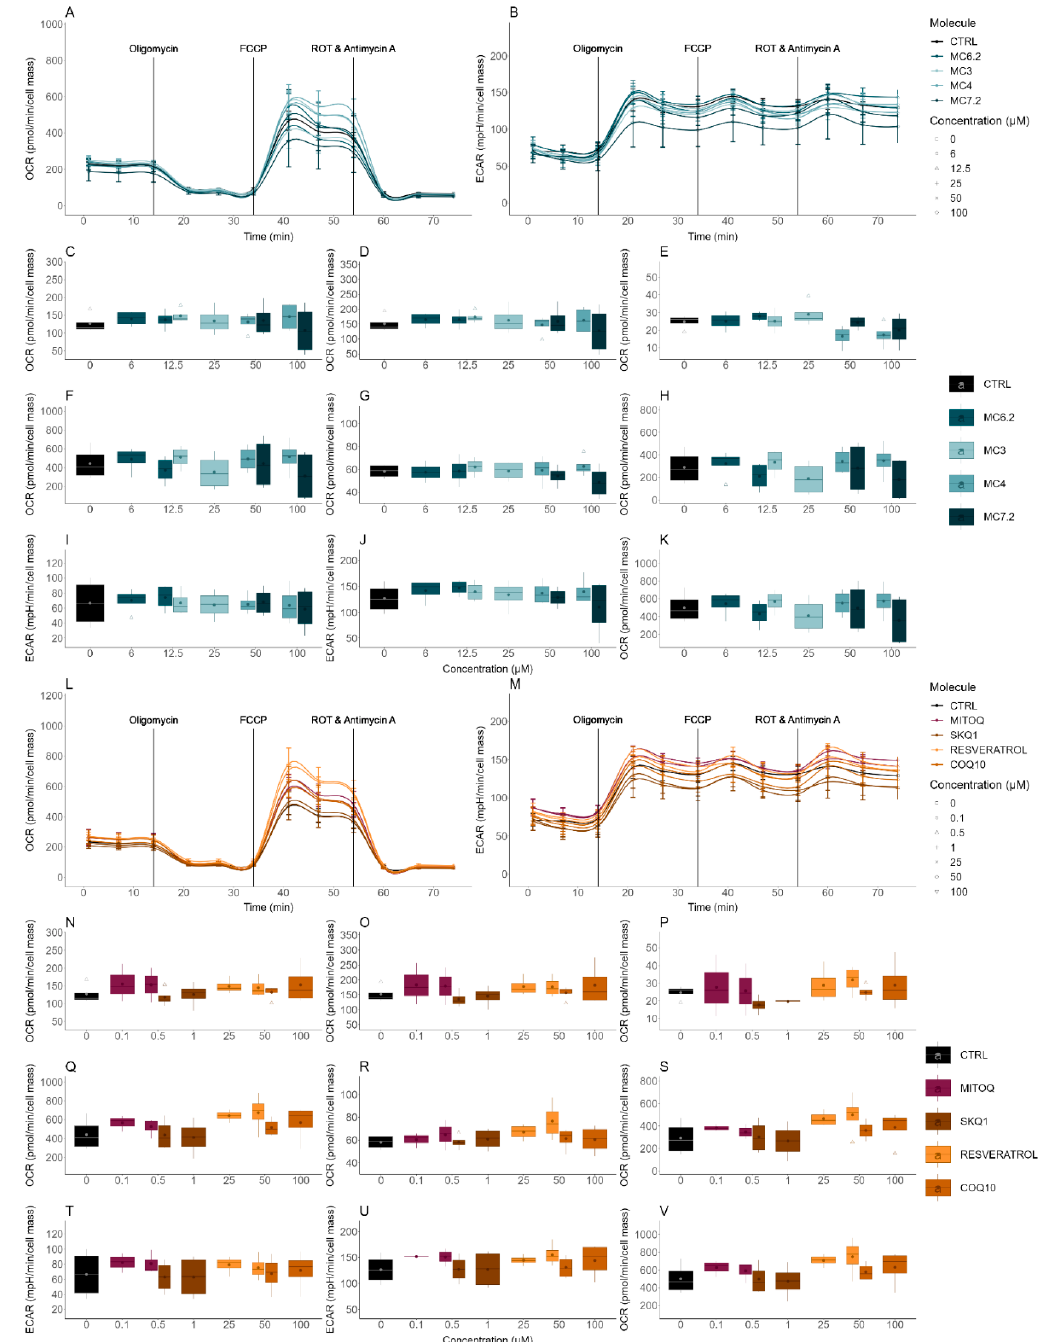
Figure 6. Effect of MitoCINs, quinone-based mitochondria-targeted and non-targeted antioxidants on oxygen consumption rate (OCR) and extracellular acidification rate (ECAR). OCR- and ECAR-associated parameters were assessed with a Seahorse XFe96 Extracellular Flux Analyzer. OCR ( A , L ) and ECAR ( B , M ) were assessed in human Caucasian hepatocyte carcinoma (HepG2) cells treated with increasing concentrations of the different molecules for a period of 48 h. Several OCR parameters were evaluated: ATP production-linked OCR ( C , N ), basal respiration ( D , O ), proton leak-based OCR ( E , P ), maximal respiration ( F , Q ), non-mitochondrial respiration ( G , R ) and spare respiratory capacity ( H , S ). ECAR parameters were also evaluated, including basal ECAR ( I , T ), stressed ECAR ( J , U ) and stressed OCR ( K , V ). Data are the mean± SE of four independent experiments and the results are expressed in the interquartile range (Q1–Q3) together with the ( ⎯ ) median. Statistically significant differences between control (CTL) and treated groups were evaluated using a t-test. Significance was accepted with p < 0.05.